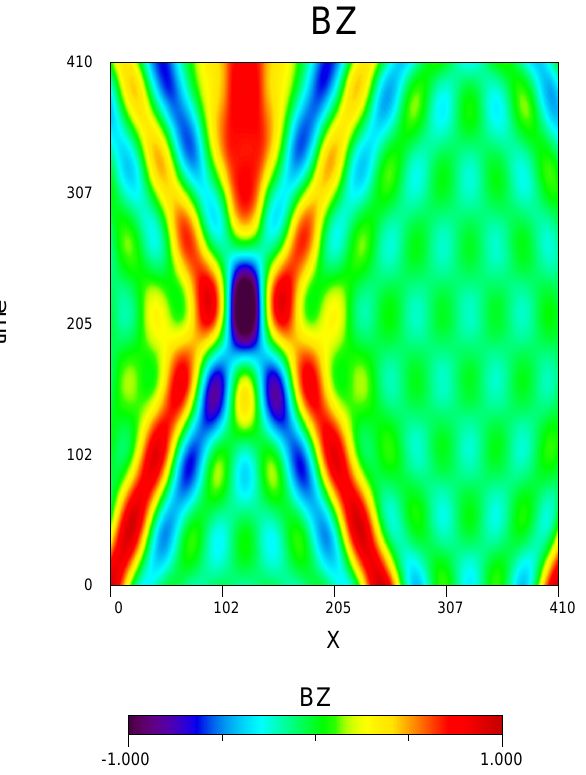
Fig. 2. AWC001(two wave packets). Temporal stack plot of the longitudinal electric field E X (X,t)